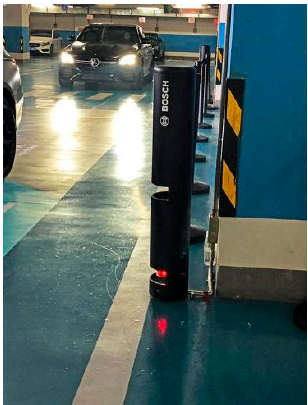
Figure 1. Industrial grade single-line laser radar.